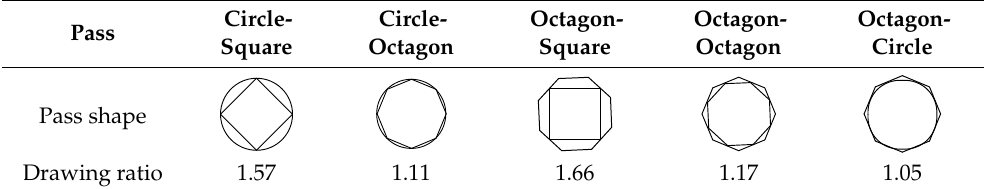
Table 1. Designations and Schemes of Four-Roll Passes.